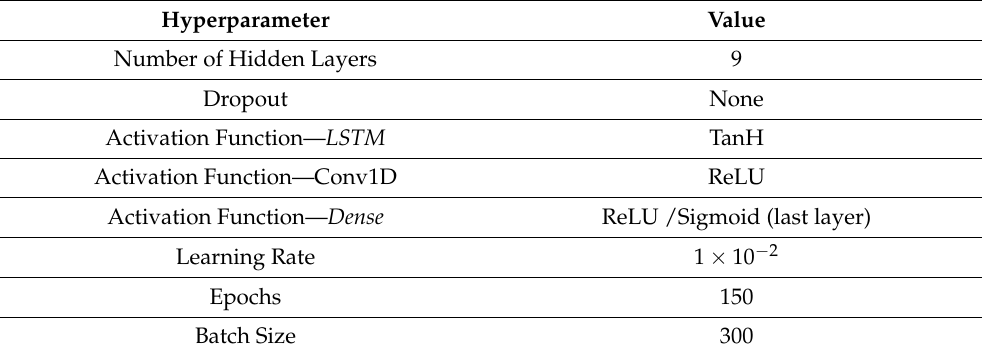
Table 6. LSTM ‐ CNN hyperparameters. Table 6. LSTM - CNN